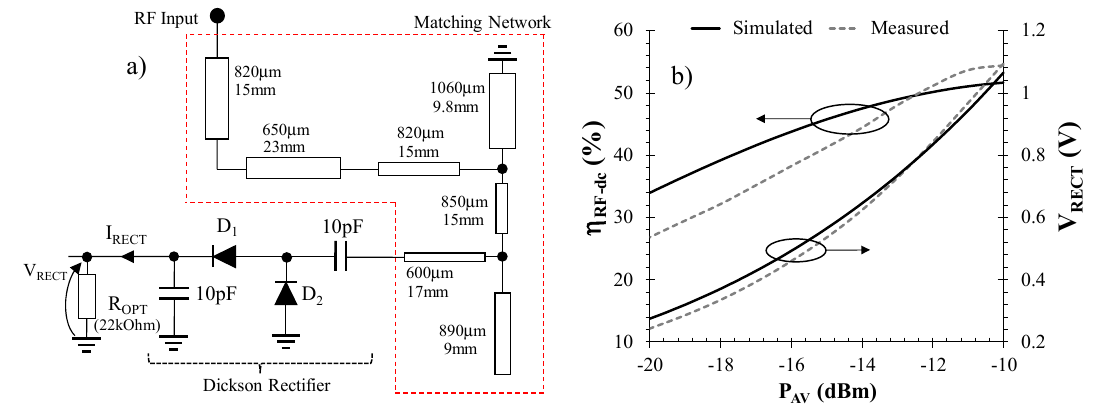
Figure 4. Rectifying section performance: ( a ) matching network and rectifier schematic topologies and ( b ) RF-to-dc conversion efficiency and output dc voltage versus input poweravailable.